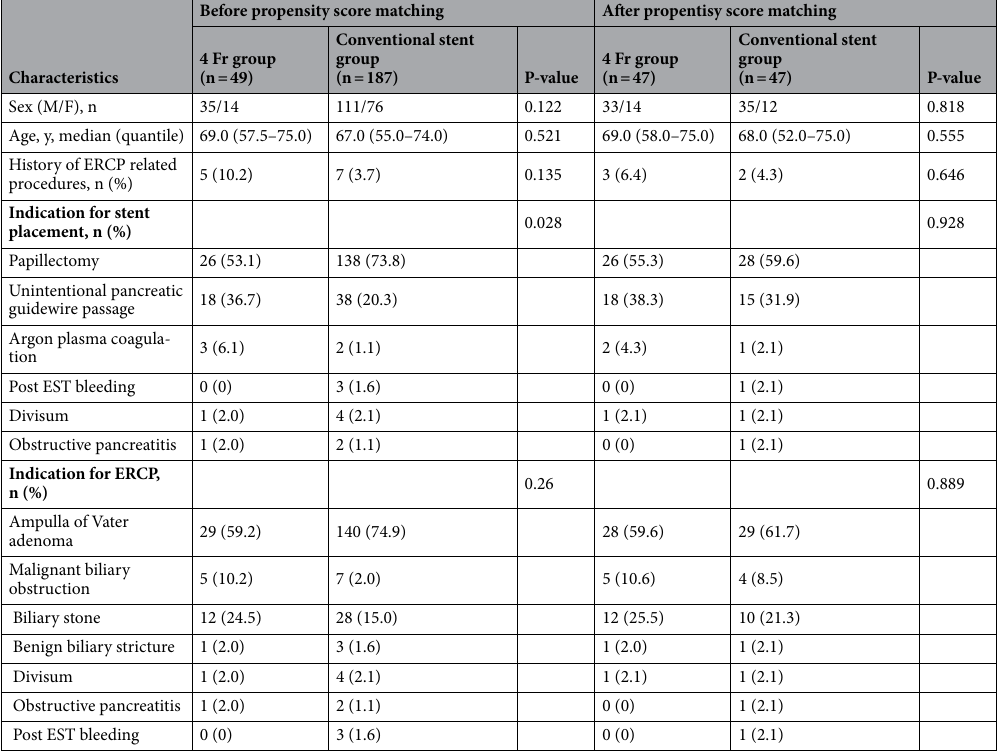
Table 1. Baseline characteristics of the study patients. ERCP, endoscopic retrograde cholangiopancreatography; EST, endoscopic